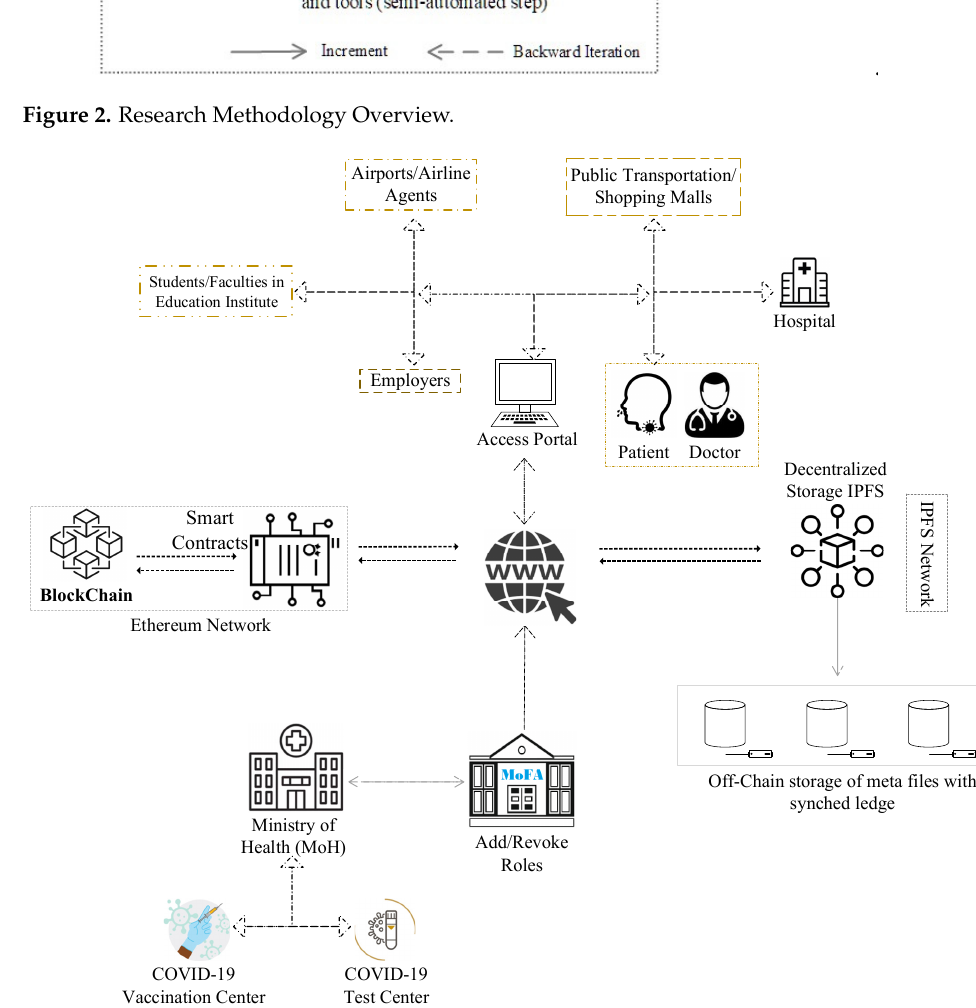
Figure 3. Overview of the proposed solution.